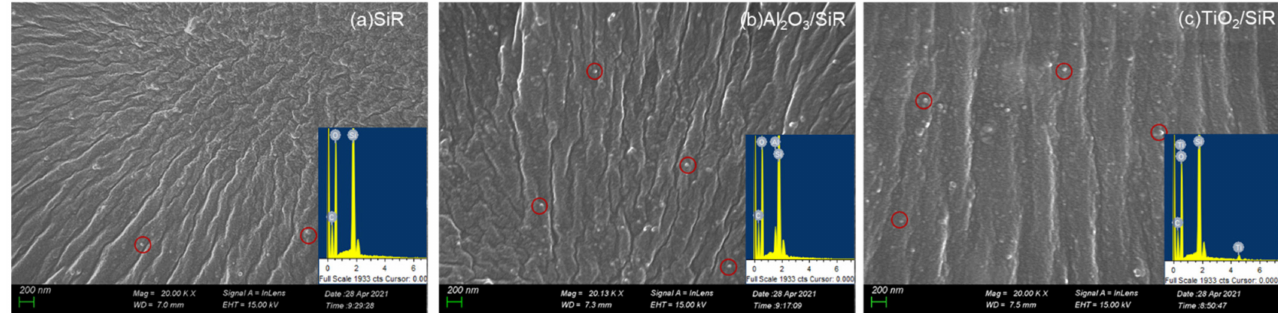
Figure 1. SEM images of the fractured faces of the samples: ( a ) SiR, ( b ) Al 2 O 3 /SiR, ( c ) TiO 2 /SiR.